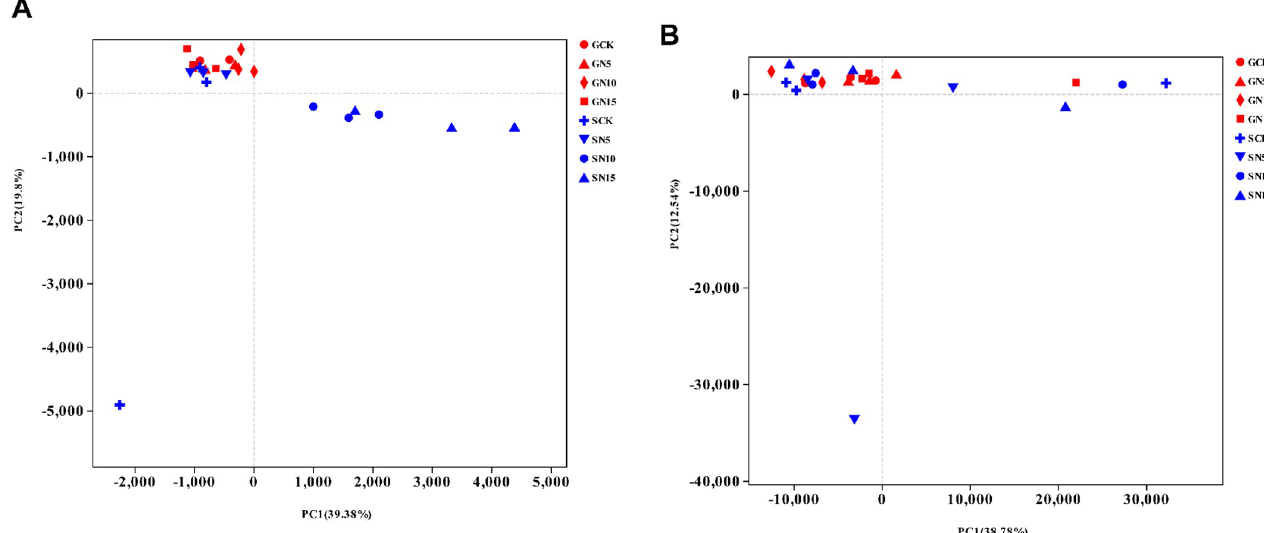
Fig 4. A. Results of the principal-components analysis (PCA) on bacterial communities. Plots are based on the UniFrac distance. Sample names are composed of the sampling site (G, sandy grassland; S, semi-fixed sandy land) and nitrogen addition: Control (CK), no N addition; N5, 5 g N m − 2 yr − 1 ; N10, 10 g N m − 2 yr − 1 ; N15, 15 g N m − 2 yr − 1 . B. Results of the principal-components analysis (PCA) on fungal communities. Plots are based on the UniFrac distance. Sample names are composed of the sampling site (G, sandy grassland; S, semi-fixed sandy land) and nitrogen addition: Control (CK), no N addition; N5, 5 g N m − 2 yr − 1 ; N10, 10 g N m − 2 yr − 1 ; N15, 15 g N m − 2 yr − 1